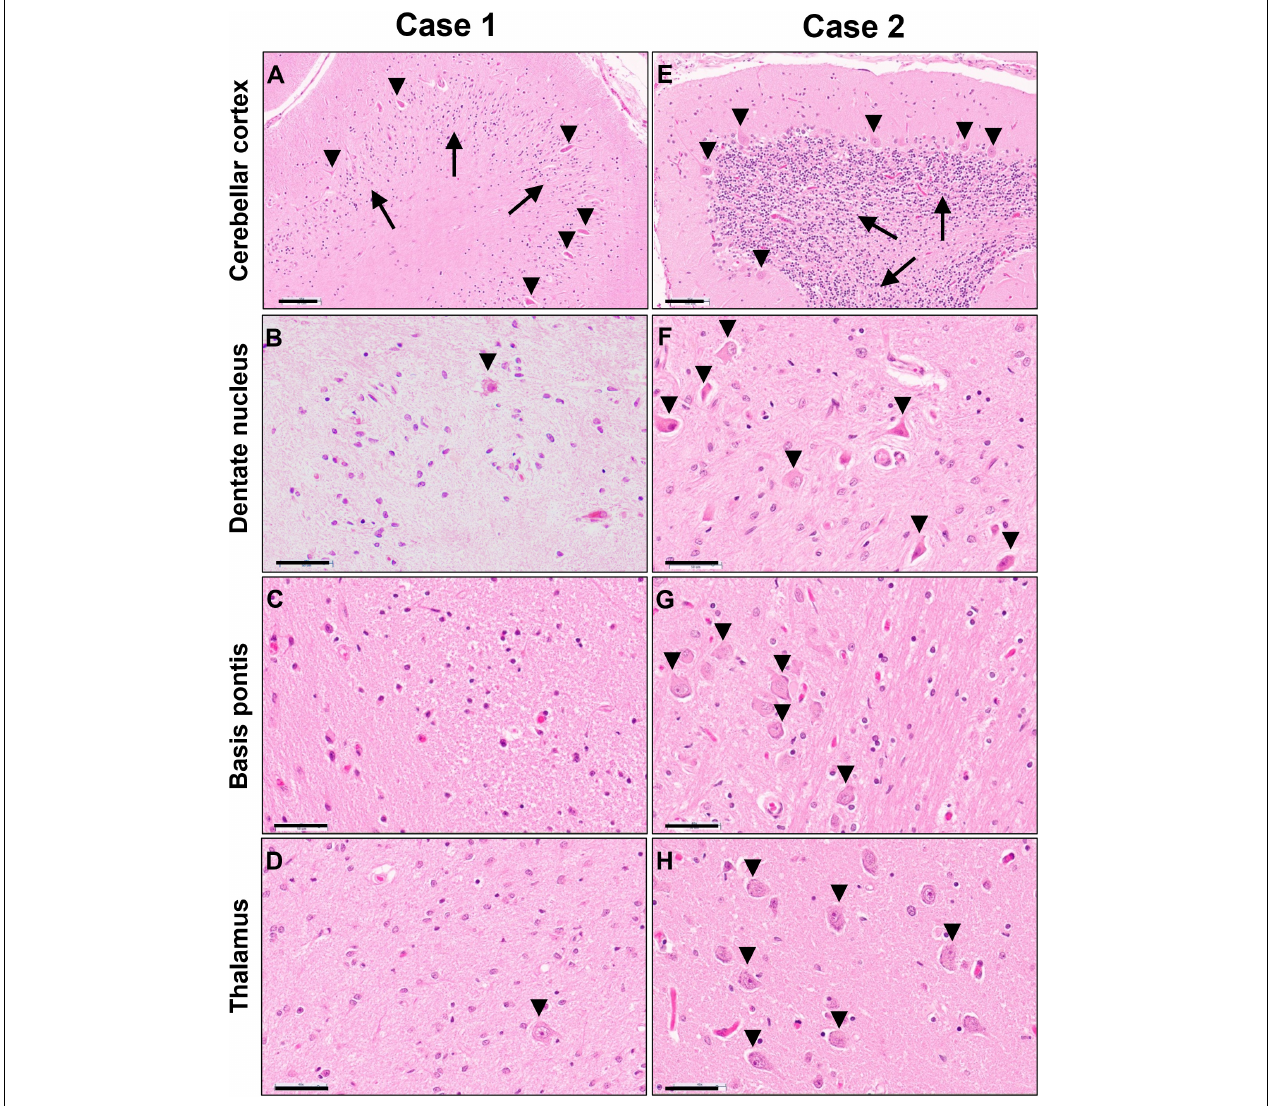
FIGURE 6 | Photomicrographs of H&E stained sections of cerebellar cortex (A,E) , cerebellar dentate nucleus (B,F) , basis pontis (C,G) and thalamus (D,H) of the untreated case 1 (left column) and transplanted case 2 (right column). Arrows in panels (A,E) indicate the granular cell layer and arrowheads point to Purkinje neurons. Arrowheads in panels (B,D,F,G,H) indicate neuronal cell nuclei, illustrating the severe neuronal loss in the untreated case. Scale bars are set to 100 µ m in panels (A,E) and to 50 µ m in all other